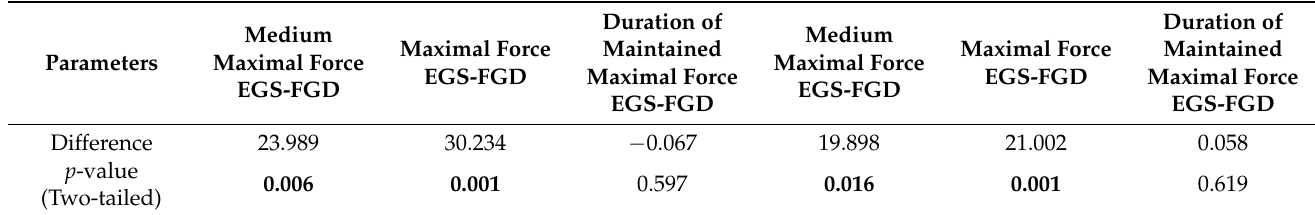
Table 12. Statistical results for agonist/antagonist muscles.